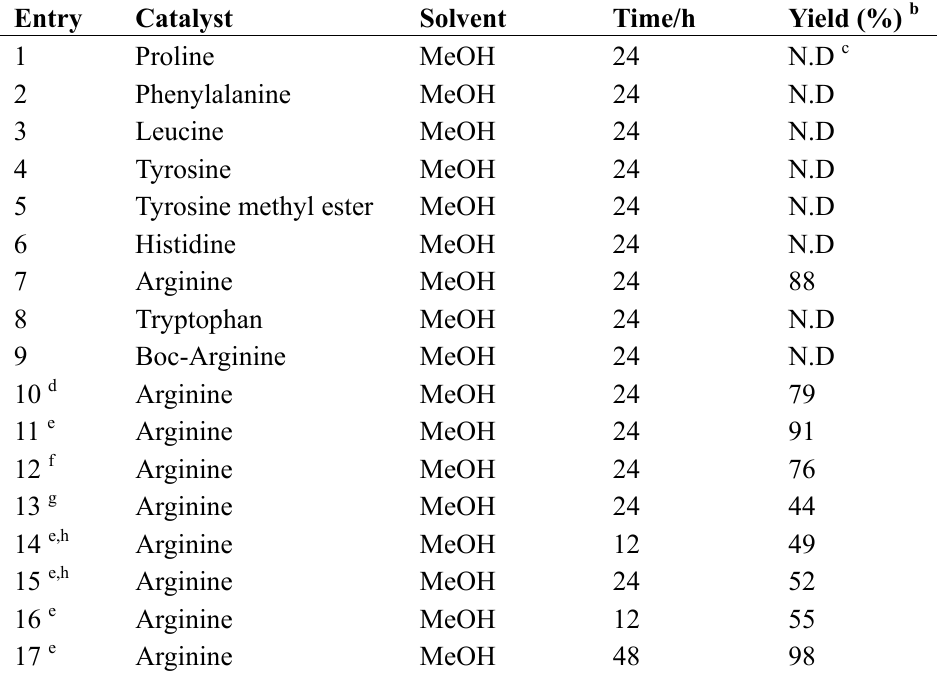
Table 1. Catalyst screening and reaction conditions optimization a